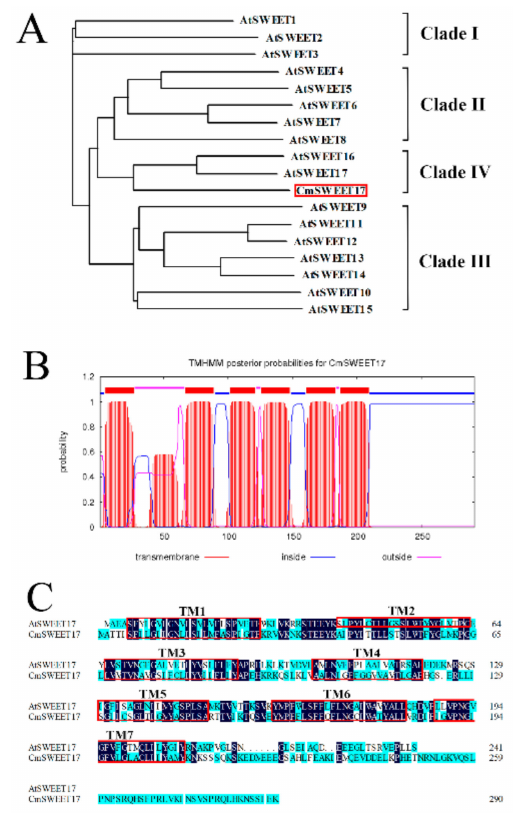
Figure 3. CmSWEET17 sequence analysis. ( A ) Phylogenetic tree of sequences including CmSWEET17 and AtSWEET family members from Arabidopsis thaliana. ( B ) Putative transmembrane TM domains within the CmSWEET17 sequence. ( C ) Amino acid sequence alignment of CmSWEET17 against AtSWEET17. Red boxes indicate TM domains and TM, transmembrane.